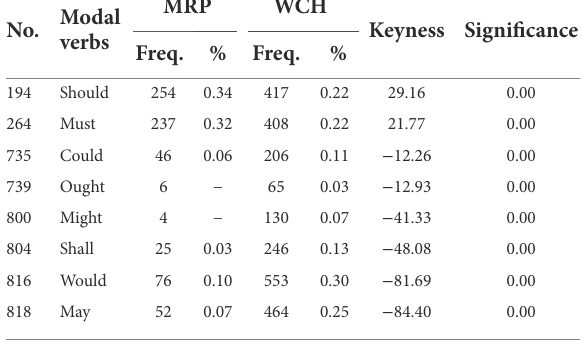
TABLE 11 Key modal verbs in SWM (in comparison with MRP).